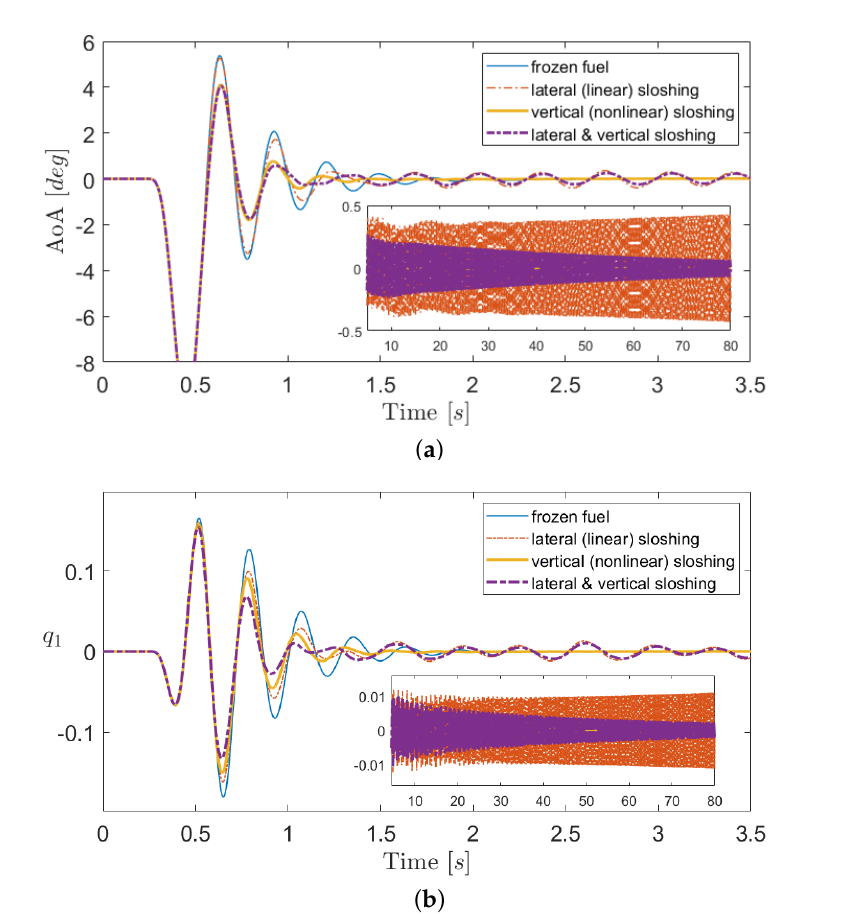
= 3m/s—Test Case 2. ( a ) Local angle of attack. ( b ) First a